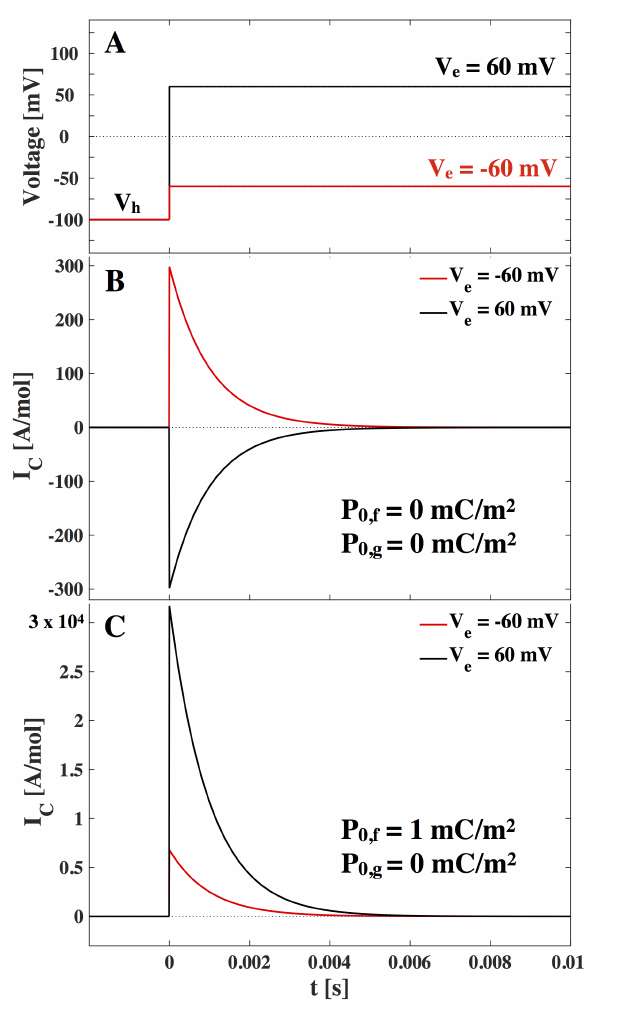
= − 100 mV to an end h = +60 mV ( ∆ V = 160 mV, black ). e = 0 mC/m 2 in the gel phase. Values 0 ,g